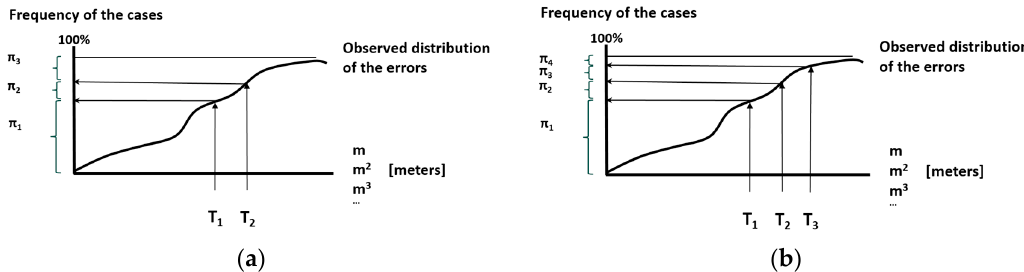
Figure 4. Conceptual example of a control by proportions: 2 tolerances ( a ) and three tolerances ( b ).